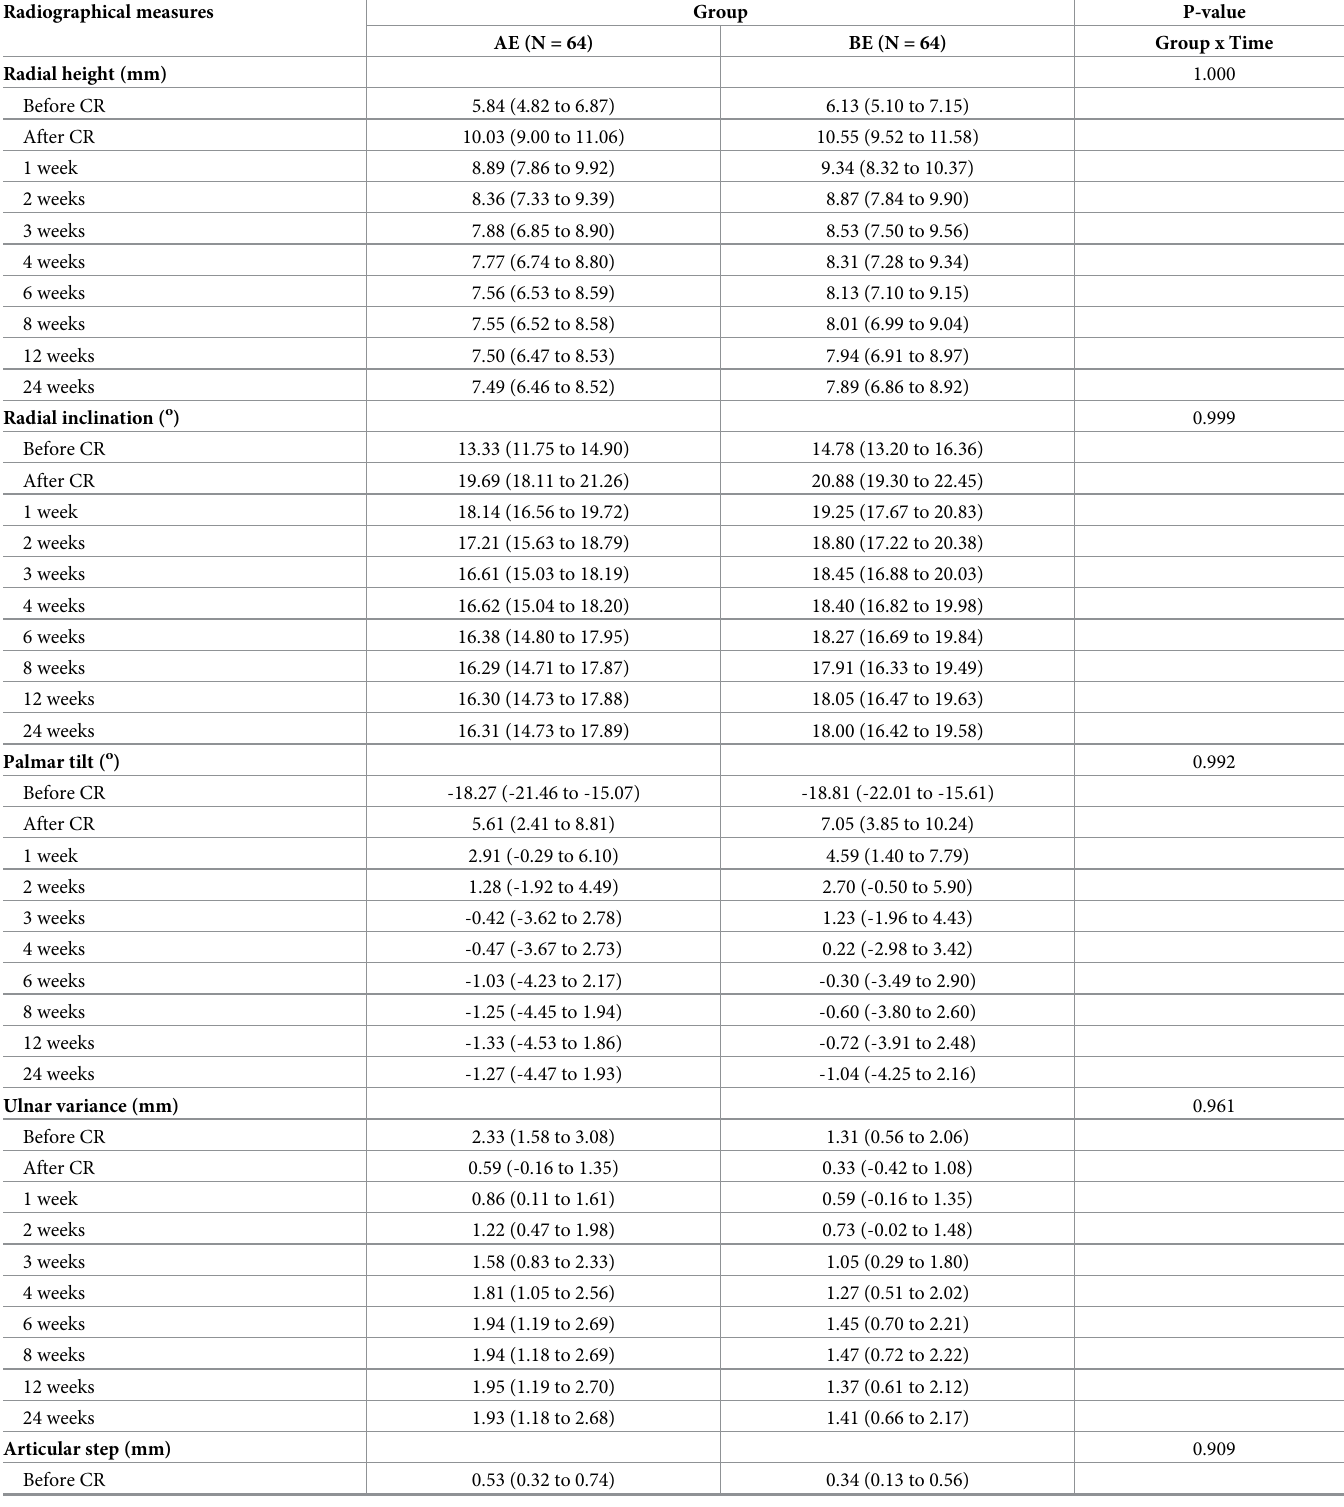
Table 5. Results of radiographic assessment, show as mean